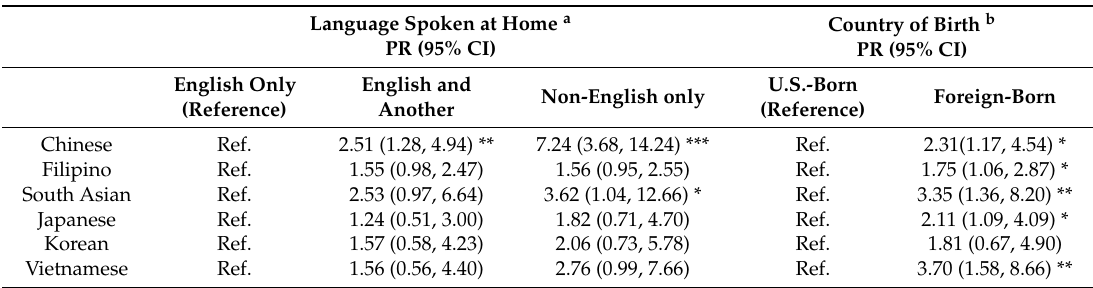
Table 3. Prevalence ratio of food insecurity by acculturation status, among Asian American subgroup, results of multivariable robust Poisson regression analysis.